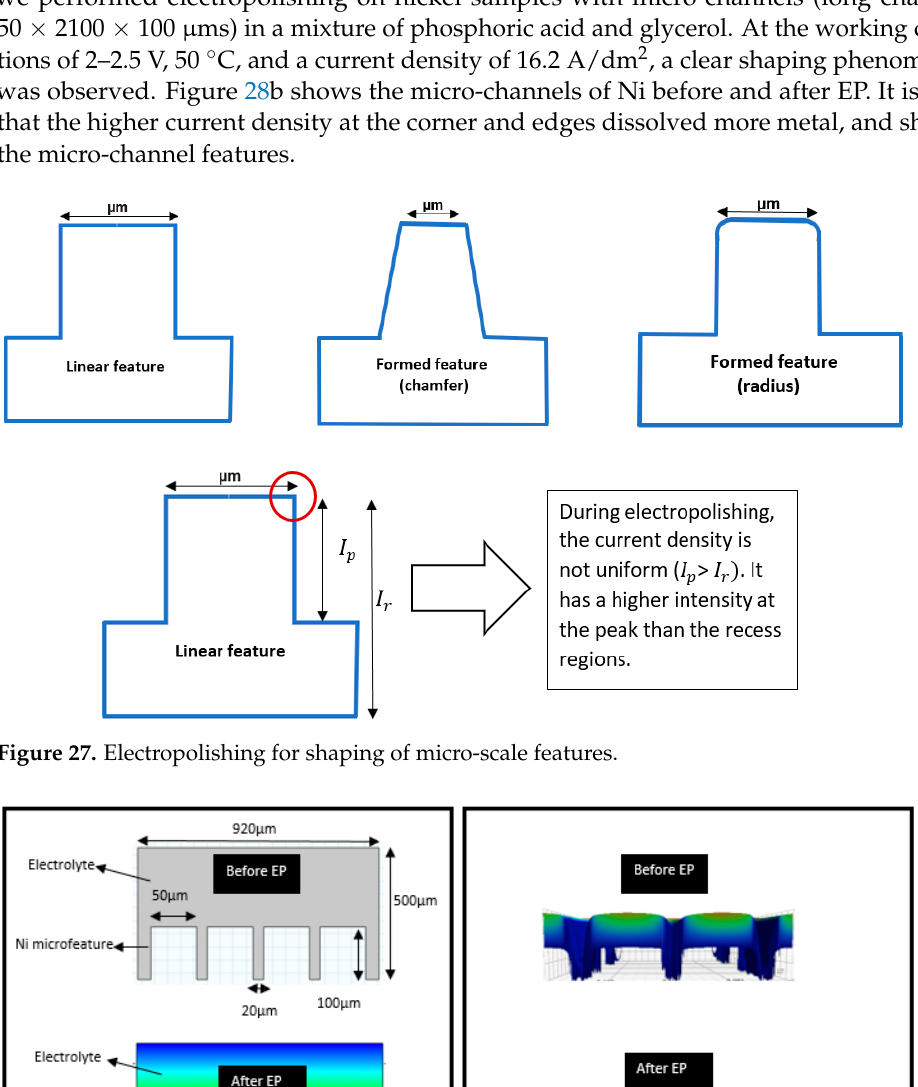
Figure 28. Electropolishing of Ni micro-features ( a ) numerical model simulated in COMSOL, ( b ) ex- perimental results of electropolishing (long channels with 200 µ ms depth) in a mixture of phosphoric acid and glycerol (work of present